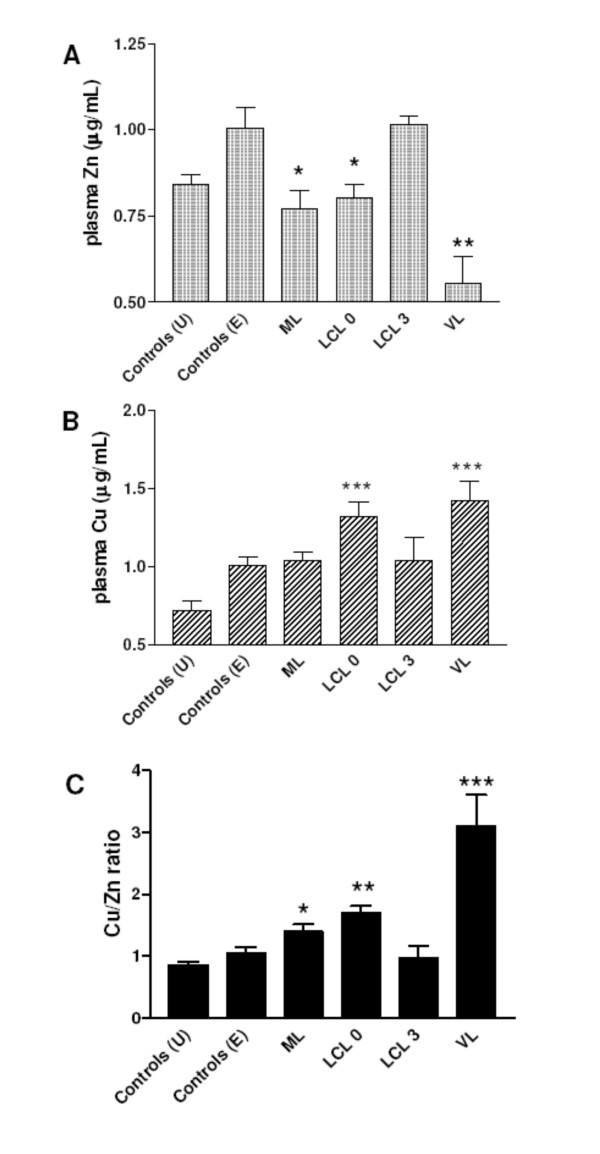
Plasma levels of Zn and Cu in controls and patients. Bars represent mean (+/-SEM) Zn (A) and Cu (B) plasma levels, and plasma Cu/Zn ratios (C) of urban (U) and endemic (E) controls; and patients with mucosal leishmaniasis (ML), localized cutaneous leishmaniasis before (LCL0) and after 3 months of treatment (LCL3), and visceral leishmaniasis (VL). *p < 0.05, **p < 0.01, ***p < .001 for LCL0 and ML vs. E and for VL vs. U (Mann-Whitney test).